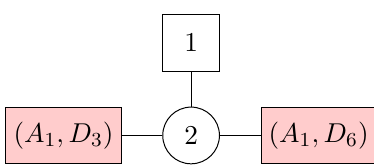
Figure 2 . The ( A 2 , A 5 ) theory is an N = 2 SCFT, which is identical to a conformal SU (2) gauging of ( A ) and ( A ) theories together with a fundamental hypermultiplet of SU (2) 1 , D 3 1 , D 6